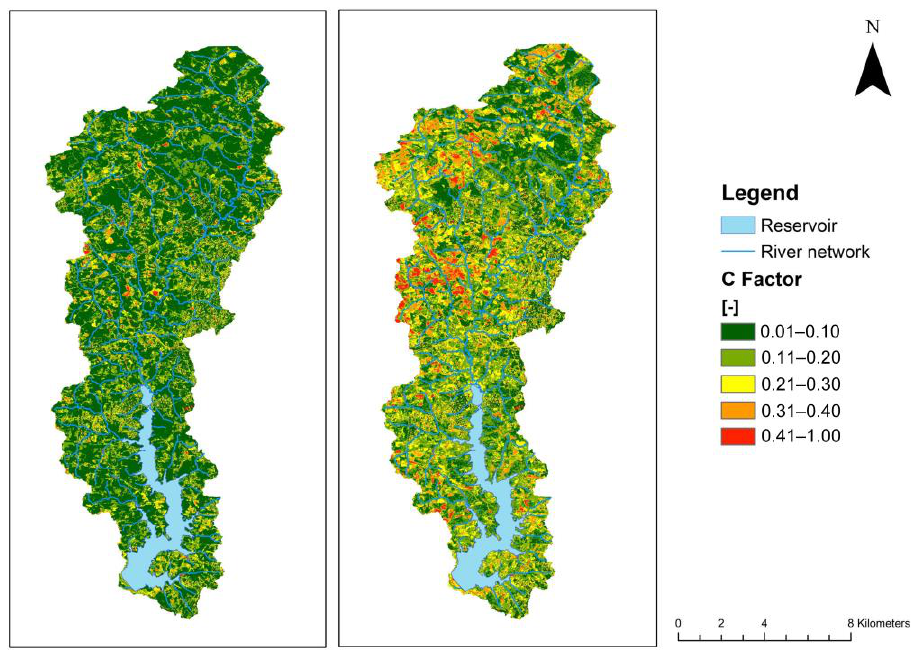
Figure 11. Spatial distribution of C factor for January ( left ) and July ( right ). Figure 12. Spatial distribution of C factor for January ( left ) and July ( right ).